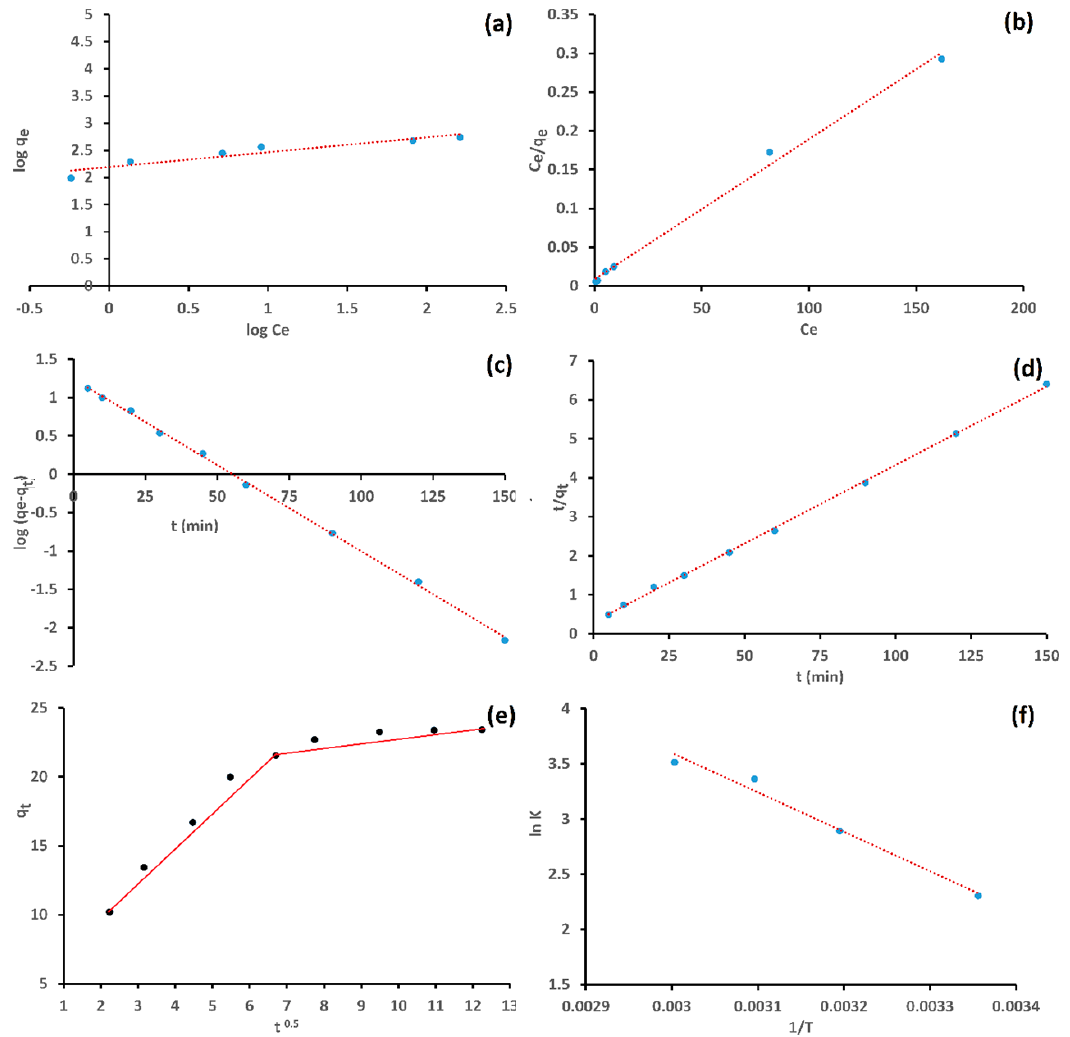
Figure 9. ( a ) Freundlich, ( b ) Langmuir, ( c ) Pseudo-first order ( d ) Pseudo-second order, and ( e ) intra-particle diffusion model. ( f ) van’t Hoff plot.